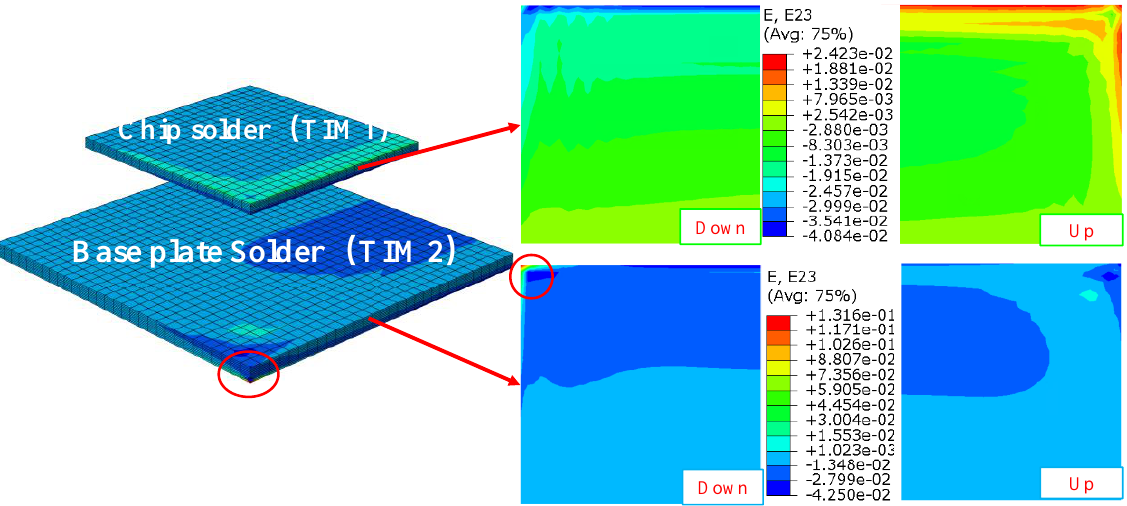
Figure 10: Shear strain distribution in the solder layer.